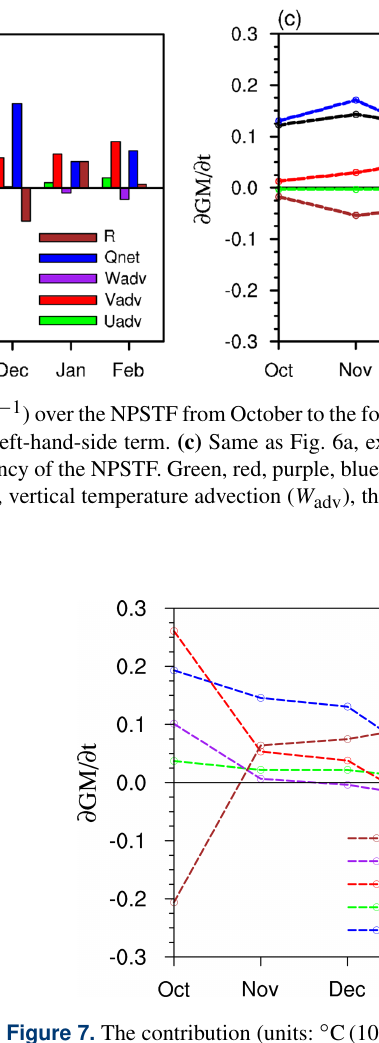
Figure 7. The contribution (units: ◦ C(100km) − 1 month − 1 ) of the net heat flux term and its individual component to the GM tendency over the NPSTF from October to the following February: the net heat flux term ( Q net , blue), sensible heat flux term ( Q S , green), latent heat flux term ( Q L , red), longwave radiation term ( Q LR , pur- ple) and shortwave radiation term ( Q SR ,